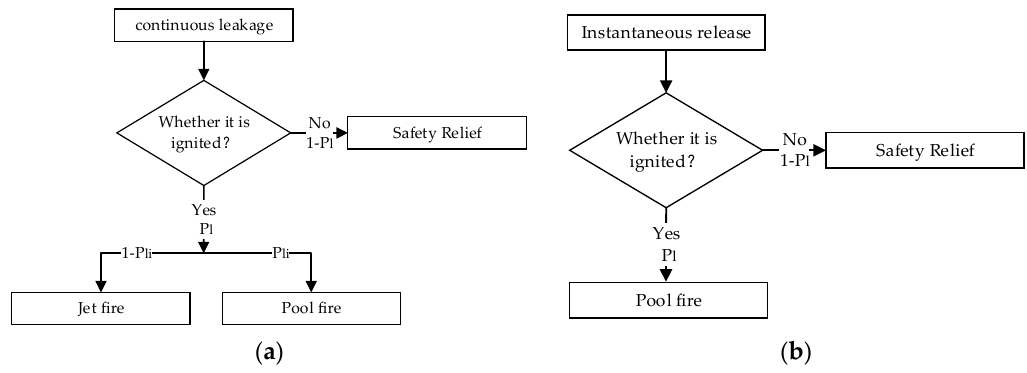
Figure 3. ( a ) Event tree of equipment failure consequence in case of continuous leakage; ( b ) Event tree of equipment failure consequence in case of instantaneous release.